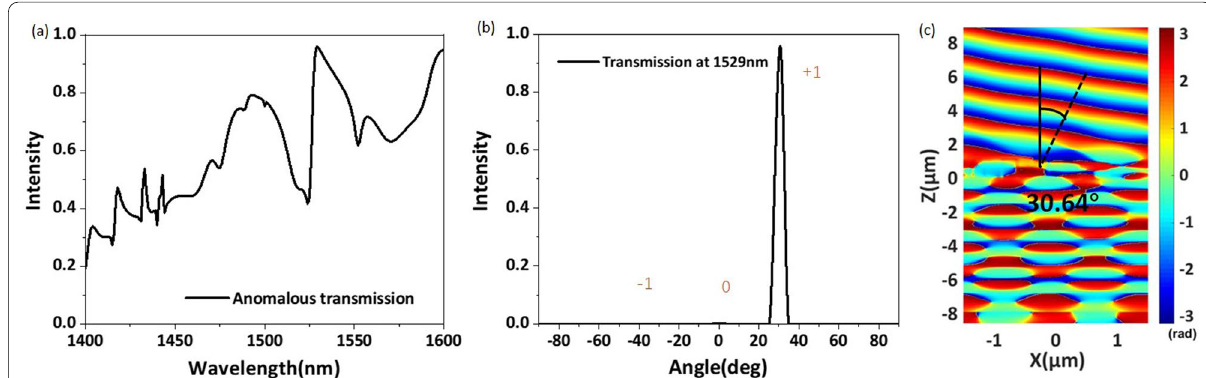
Fig. 5 a Simulated intensity of the anomalous transmission efficiency. b Far-field transmission efficiency for different anomalous refraction angles at a wavelength of 1529 nm. c Phase distribution of the metasurface configuration at a wavelength of 1529 nm. The angle in the figure shows the refraction angle of anomalous transmitted light